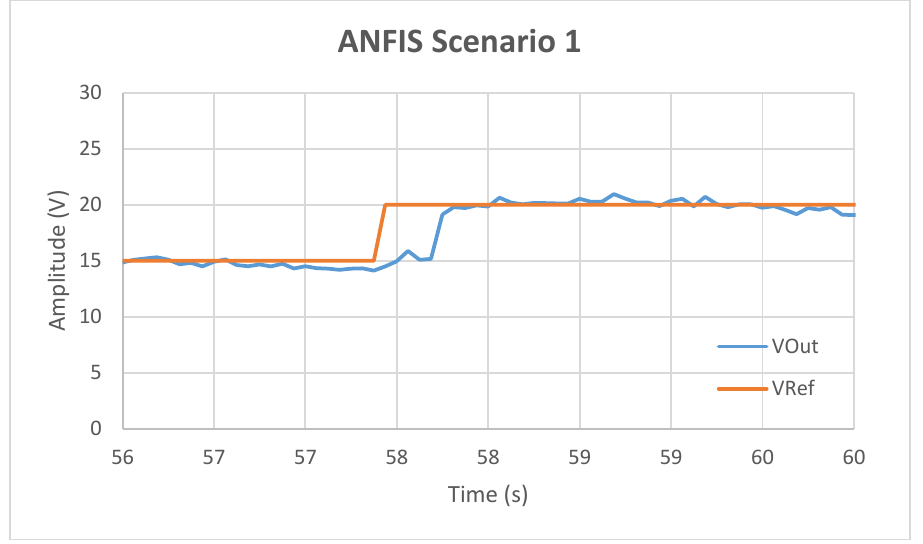
Figure 23. The response results of set point changes with ANFIS controller .